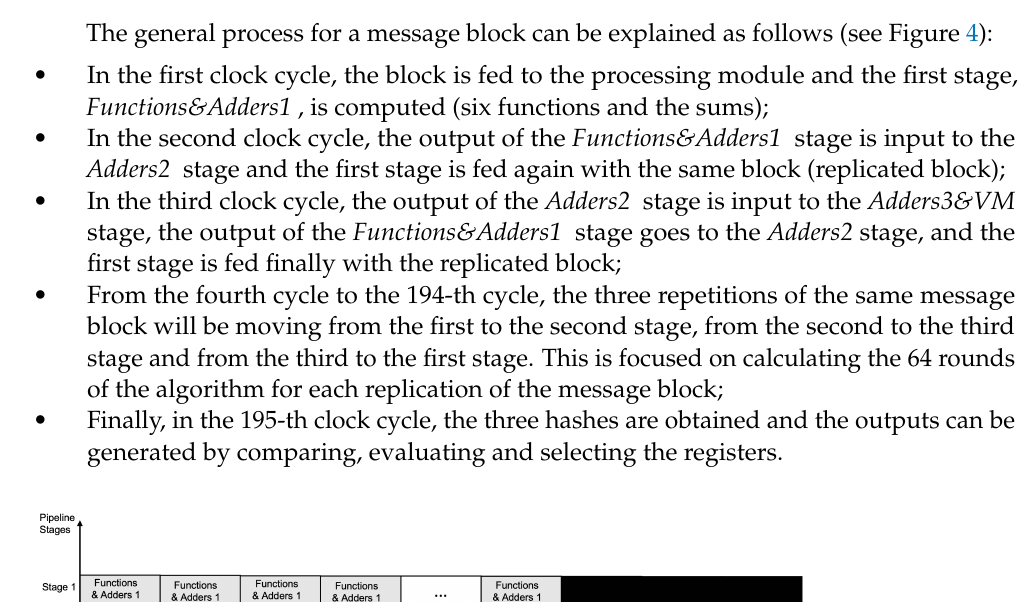
Figure 3. Block diagram of the processing module for the hybrid–redundancy hardware architecture.